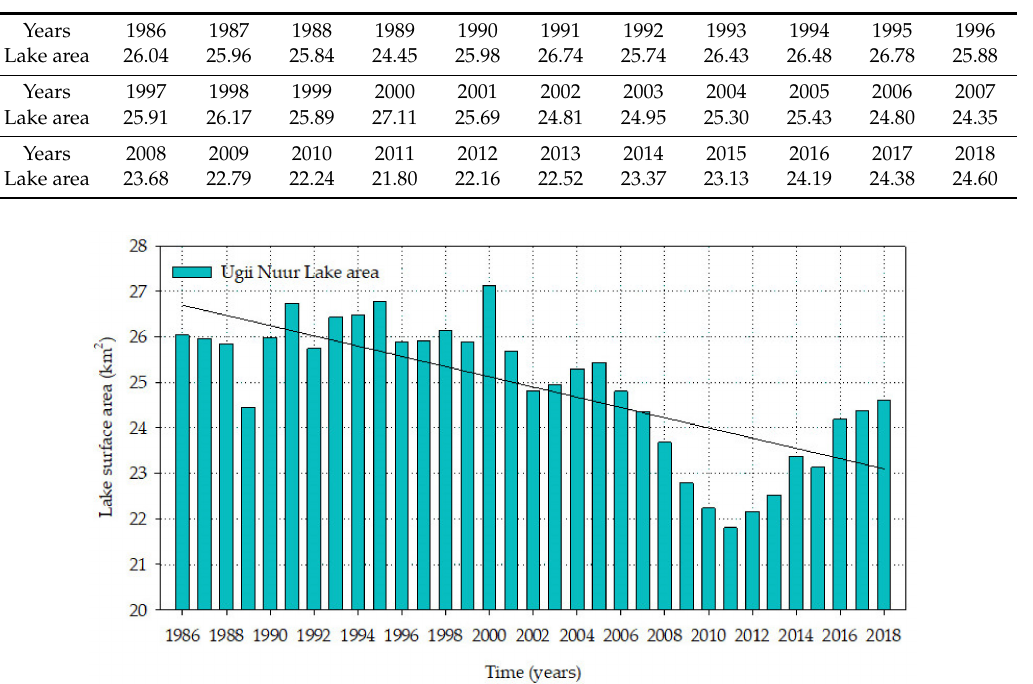
Figure 3. Variation trend of the water surface area of the Ugii Nuur Lake.